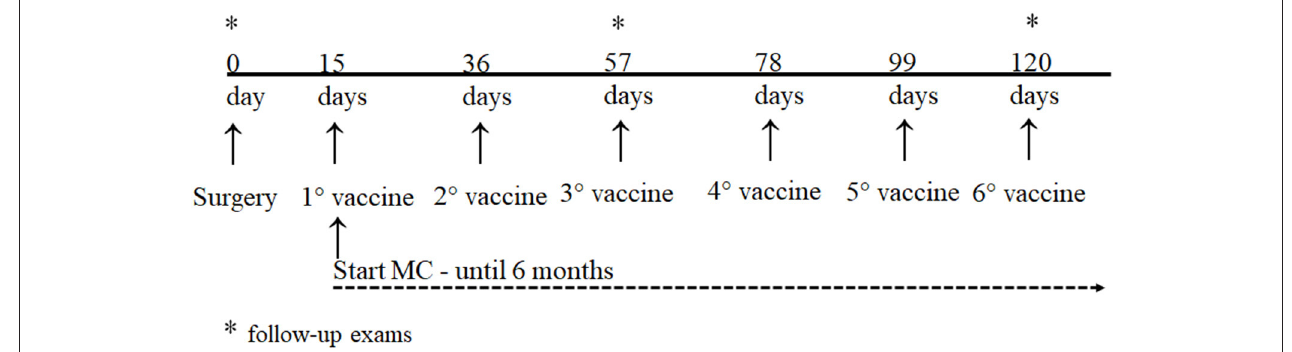
FIGURE 1 | Treatment and follow-up protocol for dogs with oral melanoma.